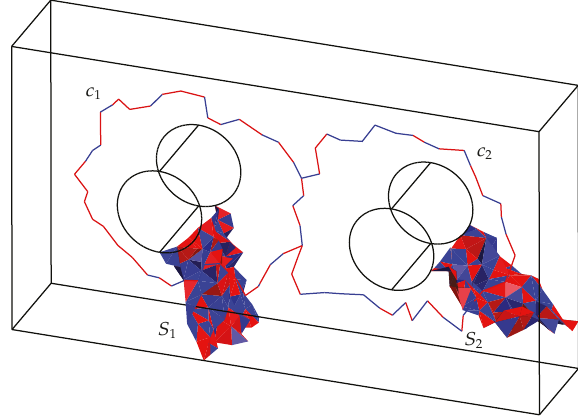
Figure 6: Representatives c 1 and c 2 of generators of H 1 (cid:6)Ω(cid:7) and the corresponding representatives S 1 and S 2 of the dual generators of H 2 (cid:6)Ω ,∂ Ω(cid:7)